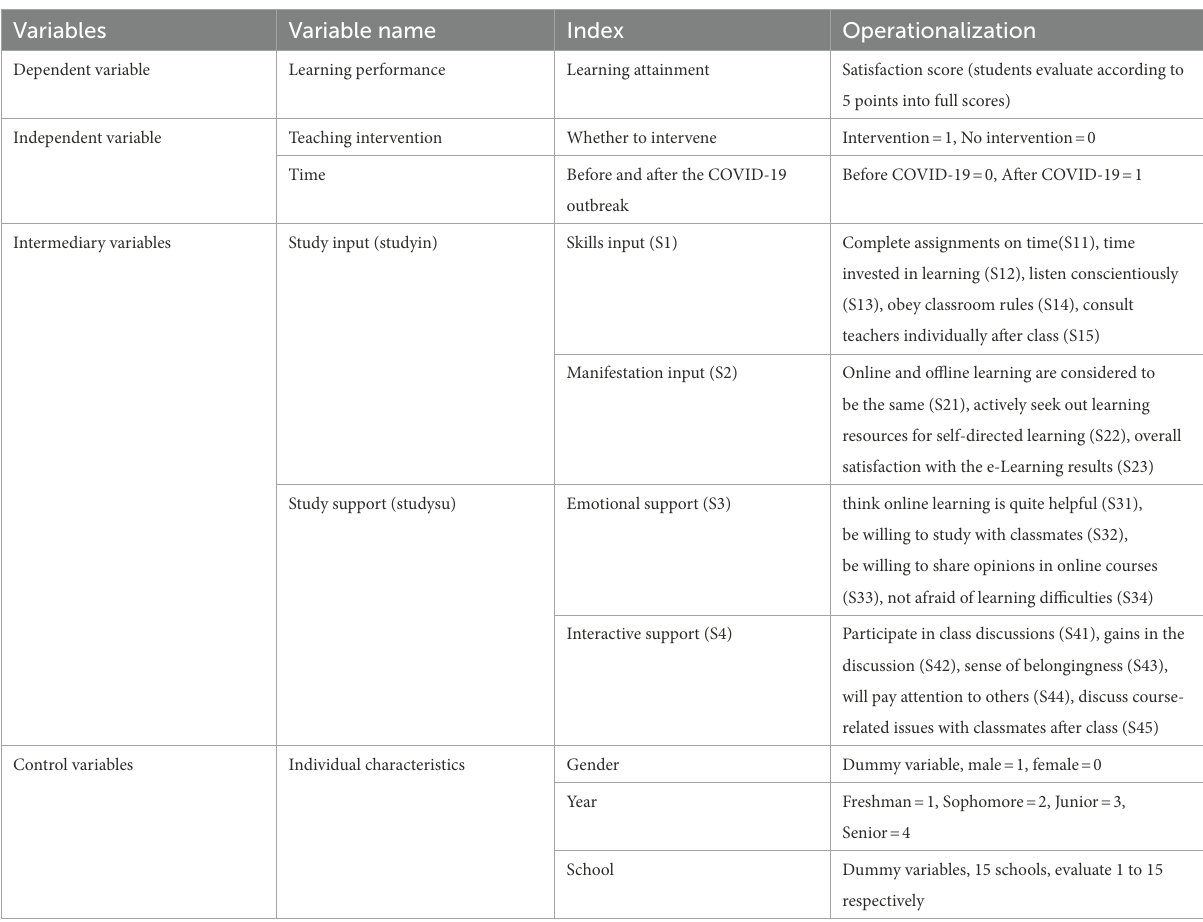
TABLE 1 Relevant variables and their operational